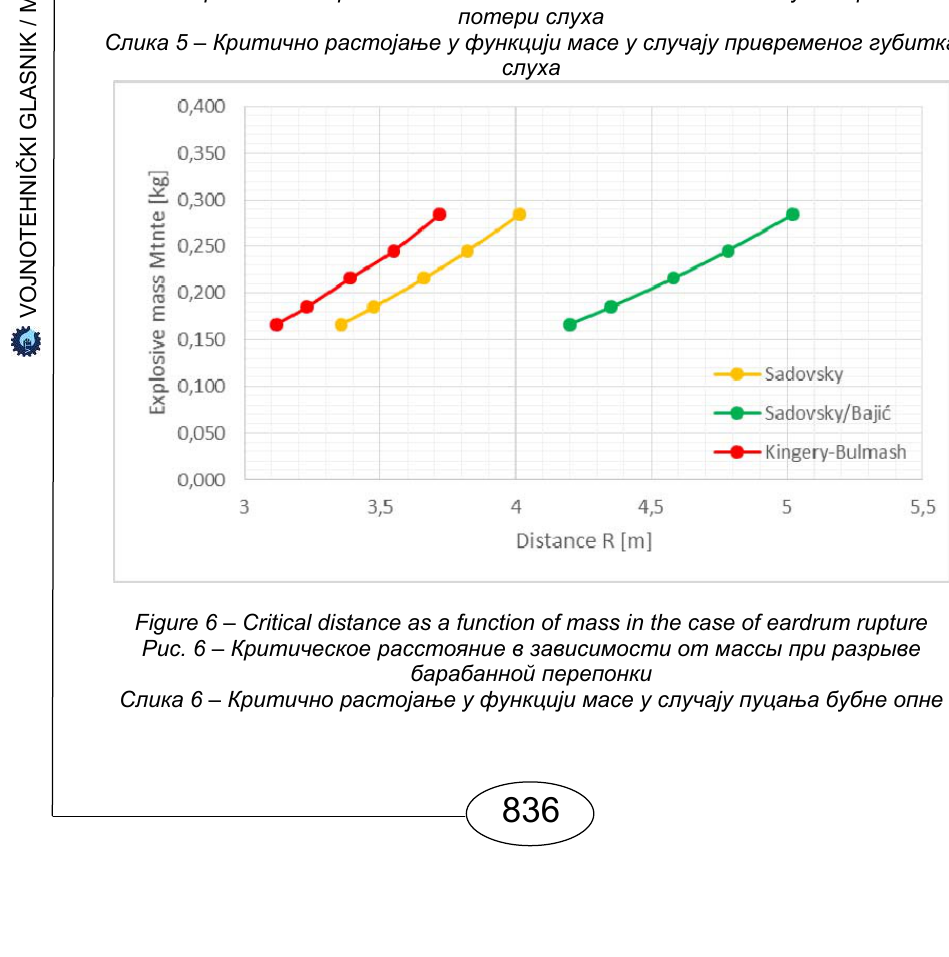
Figure 5 – Critical distance as a function of mass in the case of temporary hearing loss